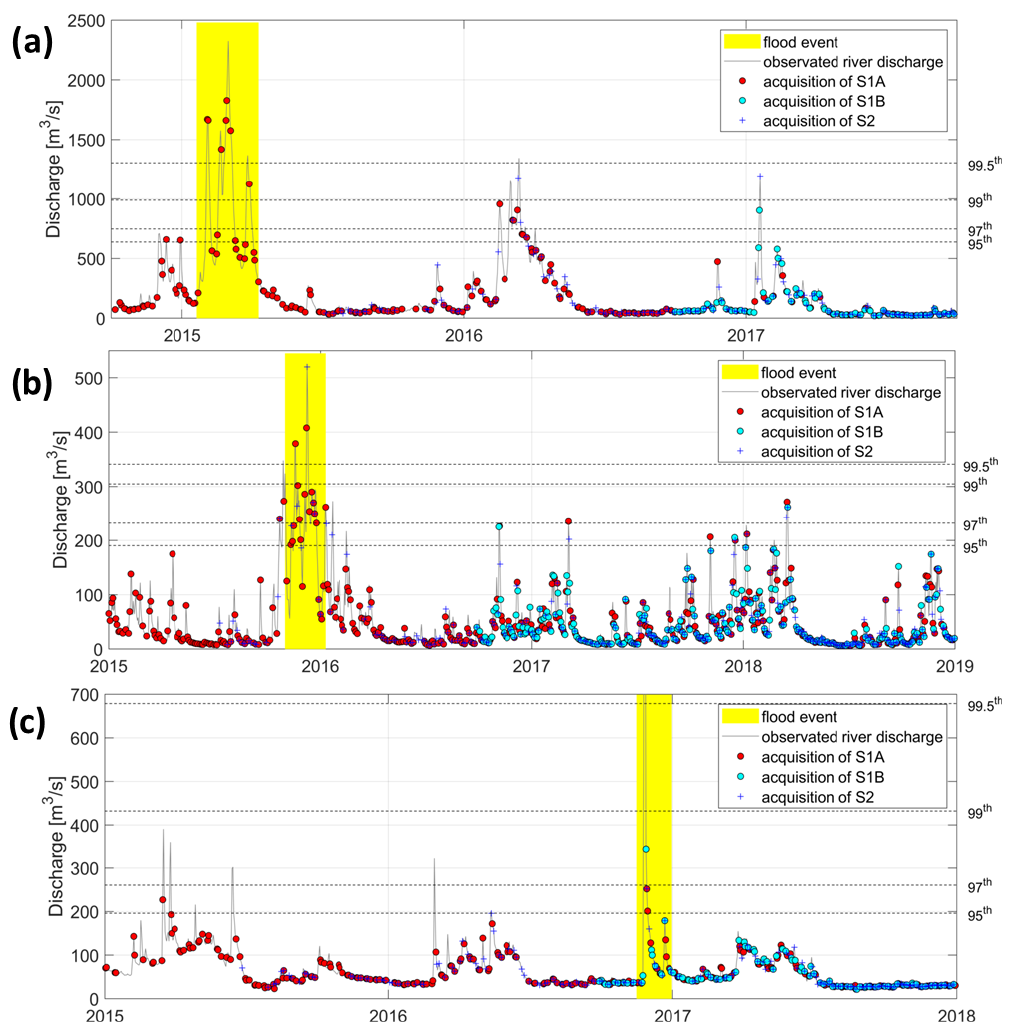
Figure 8. River discharges observed at the gauge stations of Zaragoza (a) , Skelton (b) and Moncalieri (c) along with the acquisition dates of the available images from Sentinel-1 (circles) and Sentinel-2 (plus). The period of flood event selected by Copernicus Emergency Service is identified with the yellow background, while dashed horizontal lines identify the thresholds at the 95th, 97th, 99th and 99.5th